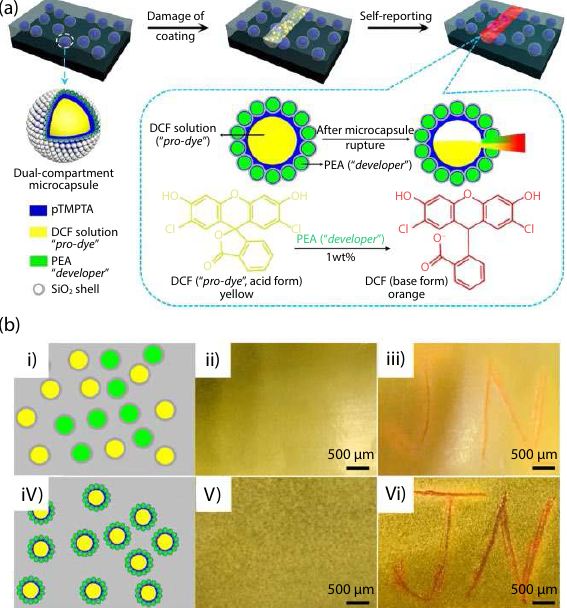
Fig. 15 Robust damage-reporting strategy enabled by dual-compartment microcapsules. ( a ) Schematic diagram of the self-reporting material with dual- compartment microcapsules and its damage visualization mechanism. ( b ) Damage visualization effects of the self-reporting material based on double microcapsules (i) and dual-compartment microcapsules (iv). Reproduced with permission from ref. [197], © 2021 American Chemical